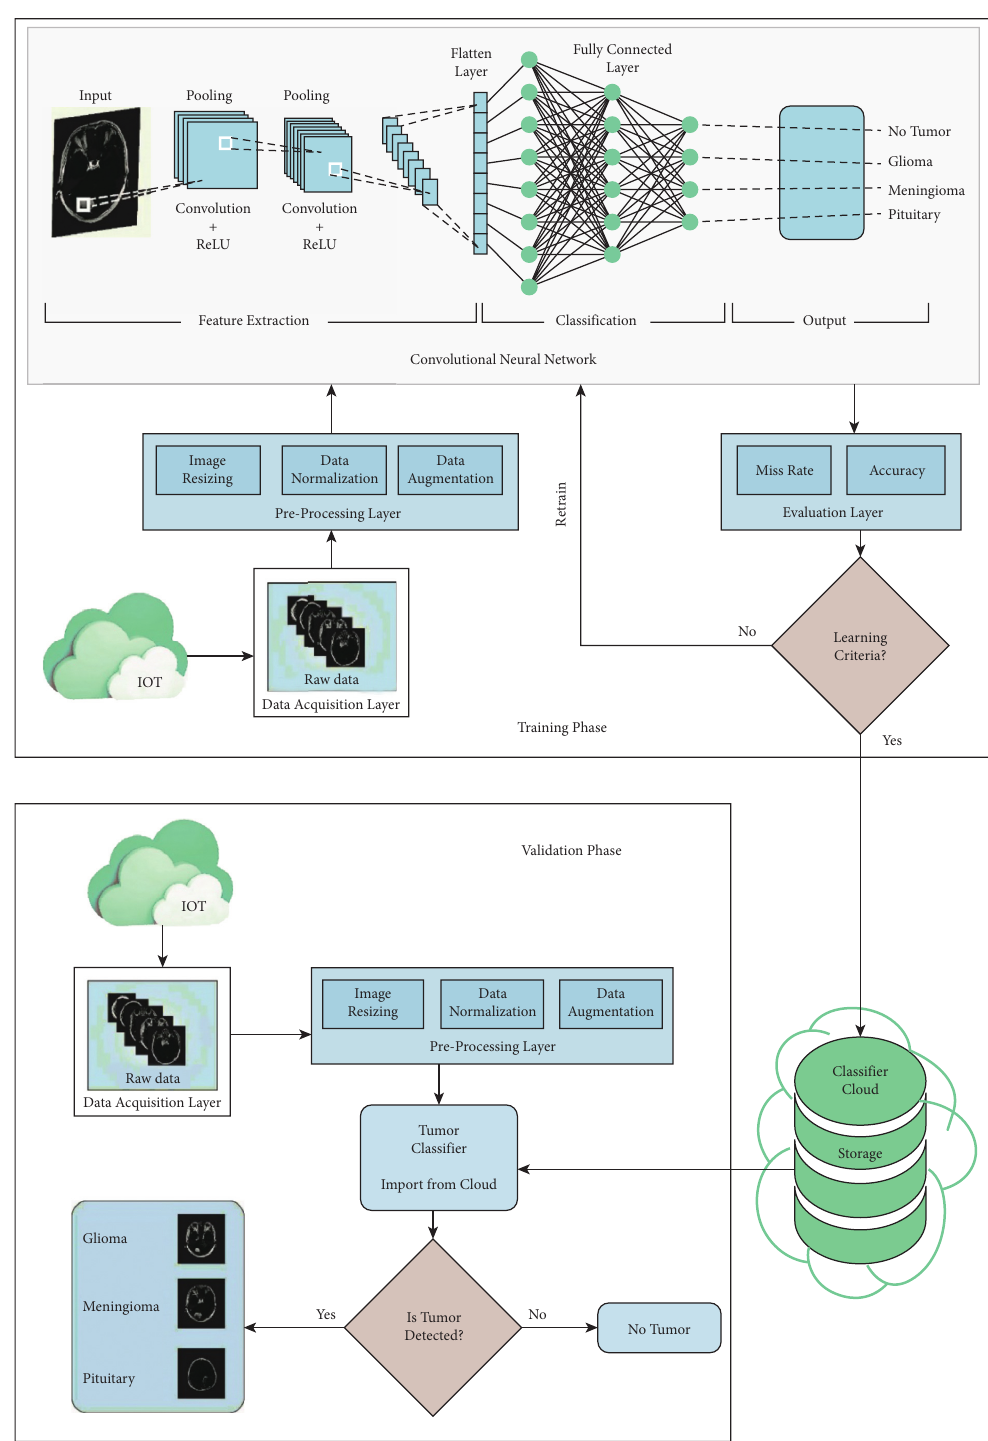
Figure 1: Detailed model of recommended